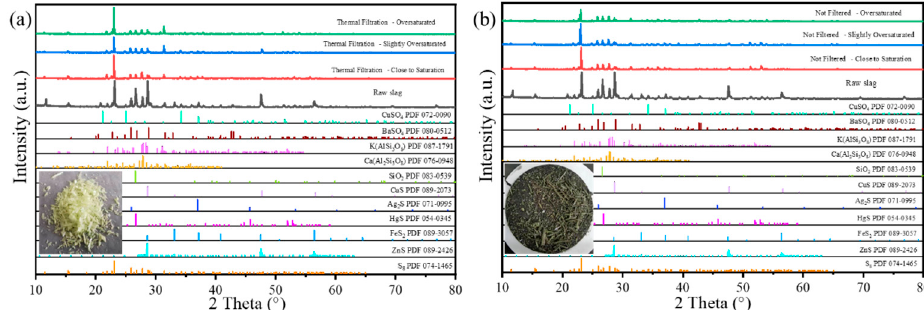
Figure 5. XRD patterns and the photos of sulfur recovered by thermal filtration ( a ) and non-filtration ( b ).